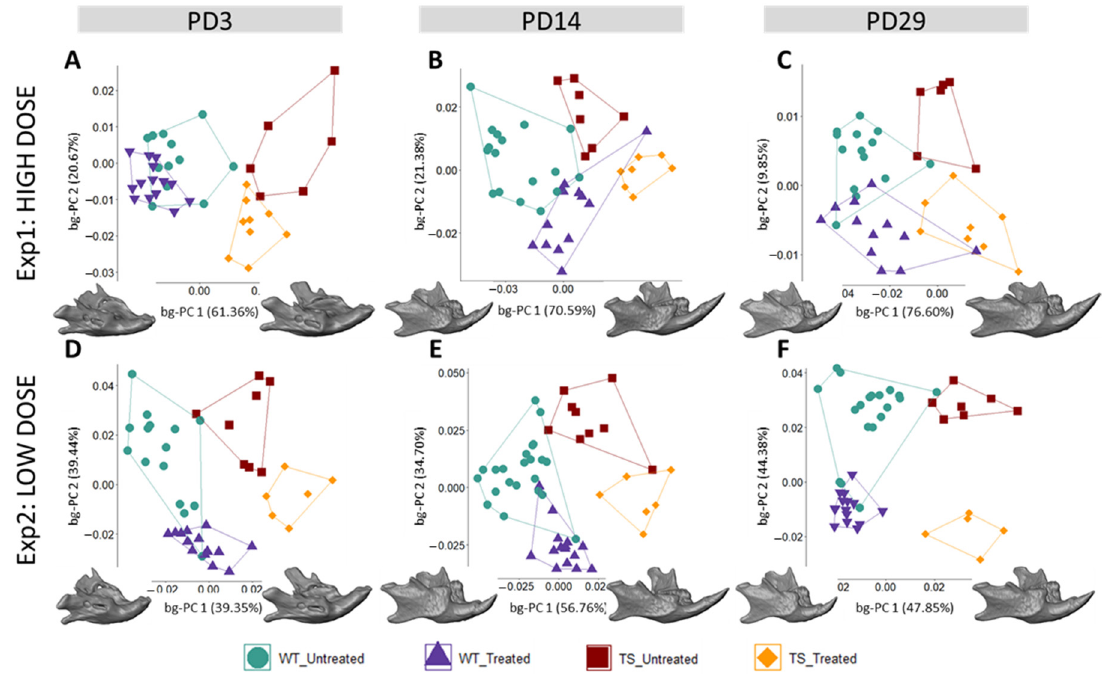
Figure 5. Postnatal mandible shape differences between wildtype and trisomic mice across devel ‐ opment and high ‐ and low ‐ dose GTE ‐ EGCG treatment effects. Mandible shape variation as shown by a between ‐ group principal component analysis (bg ‐ PCA) based on the 3D coordinates of land ‐ marks placed on the surfaces of 3D renders from in vivo μ CT scans, as described in Supplementary Table S5 at ( A , D ) PD3, ( B , E ) PD14, and ( C , F ) PD29. Longitudinal data from experimental setting 1 are presented at the top, whereas data from experimental setting 2 are presented at the bottom. All scatter plots are presented along with the morphings associated with the negative and positive ex ‐ tremes of the bg ‐ PC1 axis. Sample size: Experimental setting 1: (PD3) WT = 12, TS = 6, WT treated = 14, TS treated = 9; (PD14) WT = 17, TS = 7, WT treated = 13, TS treated = 7; (PD29) WT = 14, TS = 6, WT treated = 12, TS treated = 8. Experimental setting 2: (PD3) WT = 15, TS = 8, WT treated = 13, TS treated = 6; (PD14) WT = 22, TS = 9, WT treated = 15, TS treated = 6; (PD29) WT = 19, TS = 7, WT treated = 13, TS treated = 5.